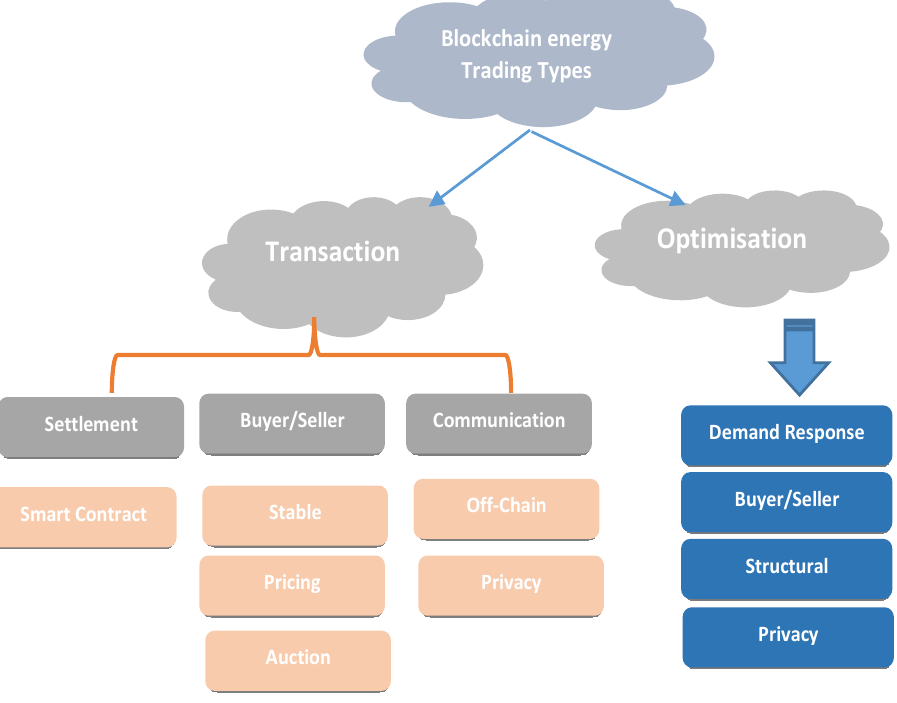
Figure 10. Blockchain-based energy trading Taxonomy.